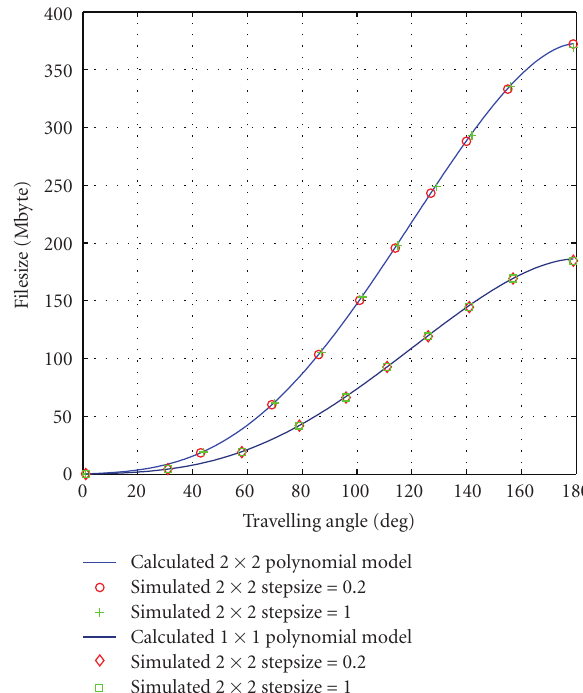
Figure 5: Comparison between simulation and theoretically com- puted results for Polynomial throughput-distance